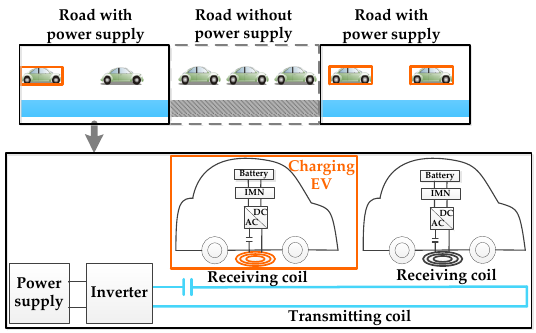
Figure 1. Diagram of an on-road charging for EVs.